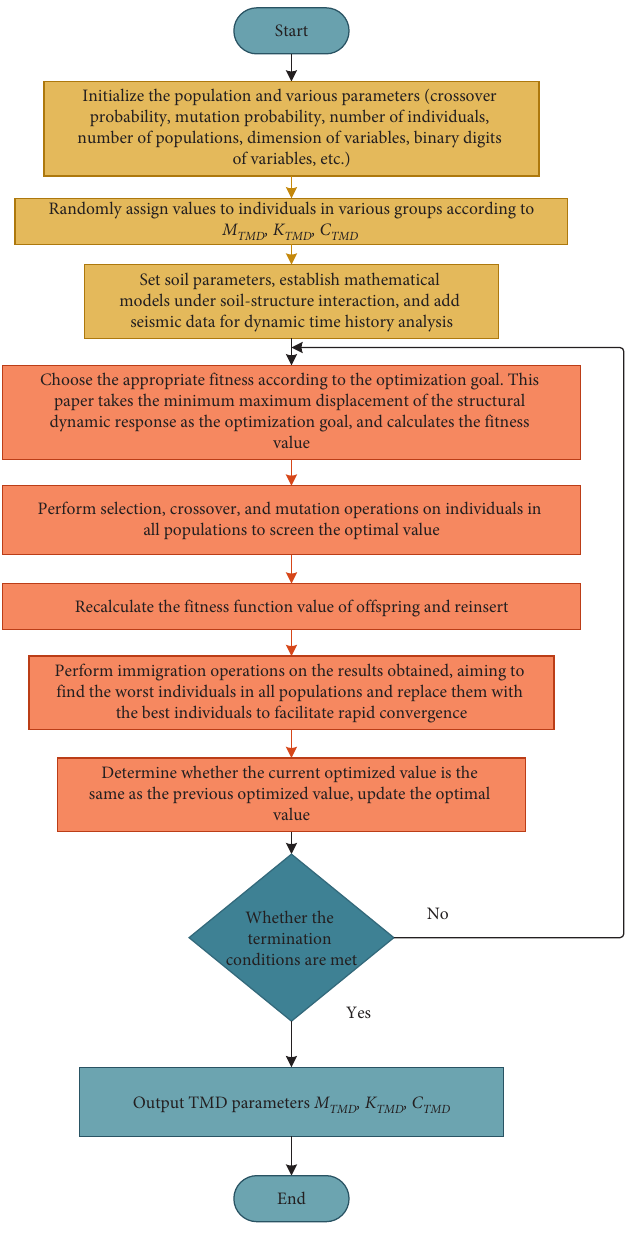
Figure 6: Flowchart of the multipopulation genetic algorithm. Table 5: TMD optimization parameters of Tangshan wave,